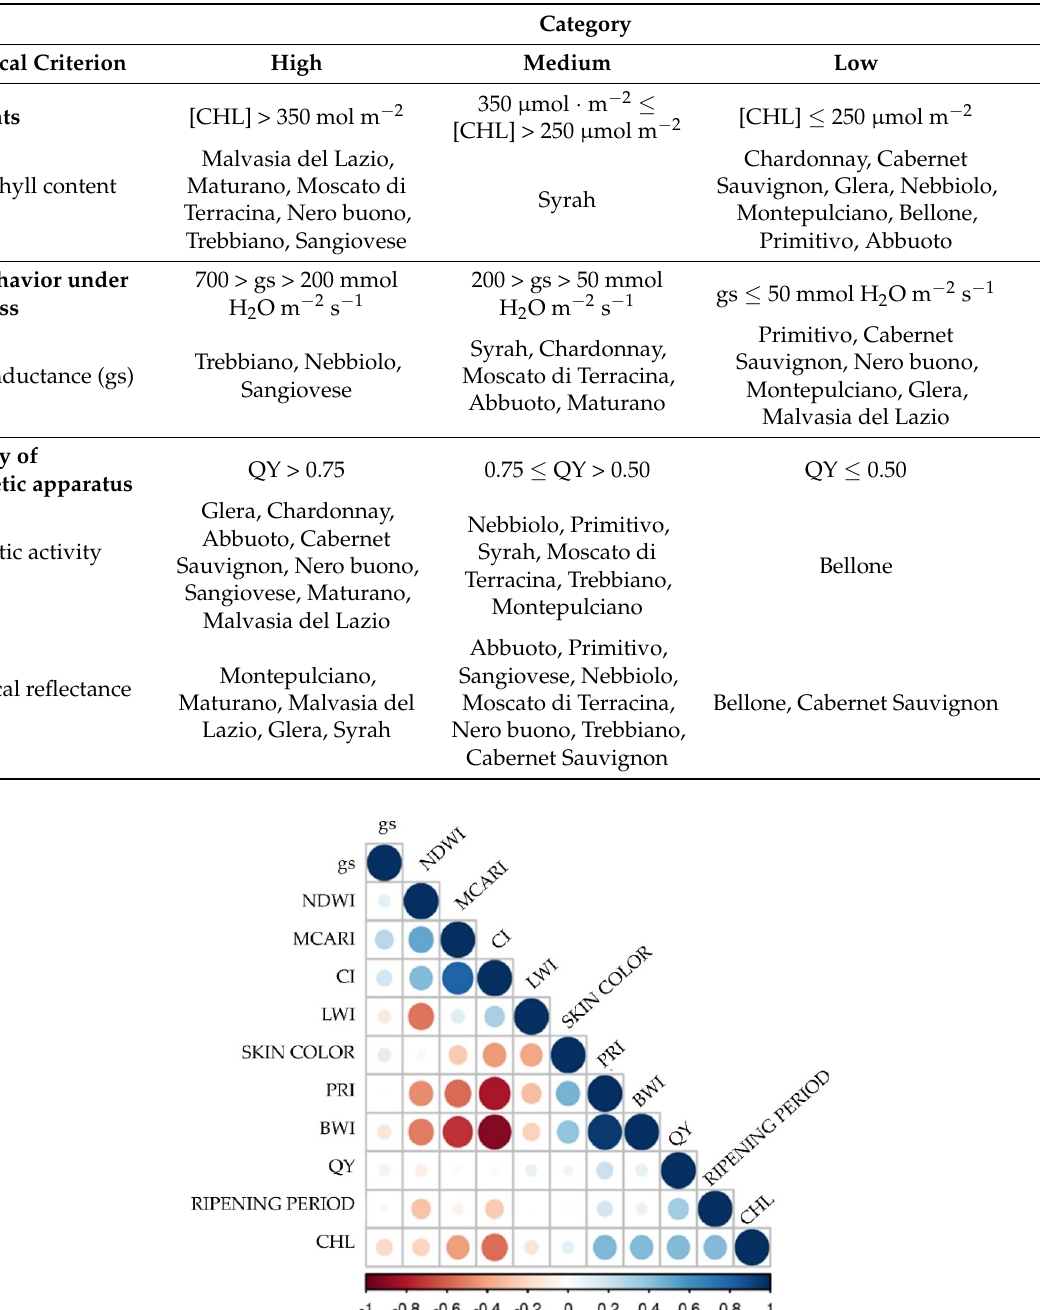
Table 3. Summary of key results categorizing cultivars according to leaf pigments (chlorophyll content), stomatal behavior under period of drought, and photochemical efficiency of PSII (quantum yield: QY). Data refer to the measure at BBCH 091 (after harvest–end of wood maturation).